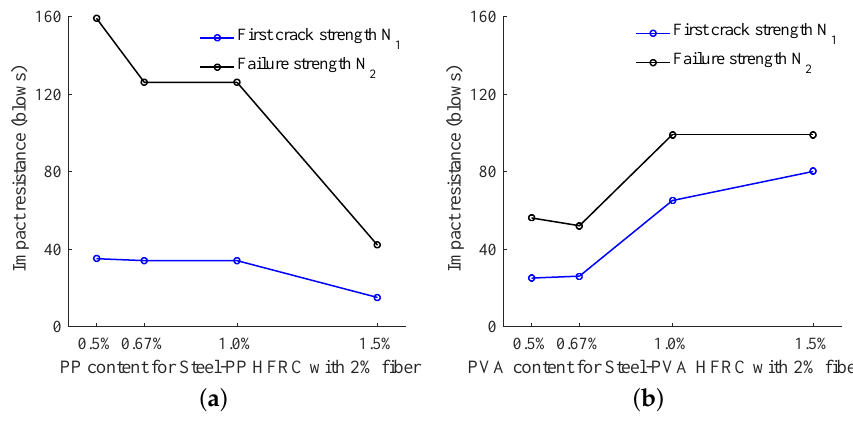
Figure 10. Hybrid effect on drop impact energy. ( a ) Steel-PP HFRC with 2% fiber content; ( b ) Steel-PVA HFRC with 2% fiber content.